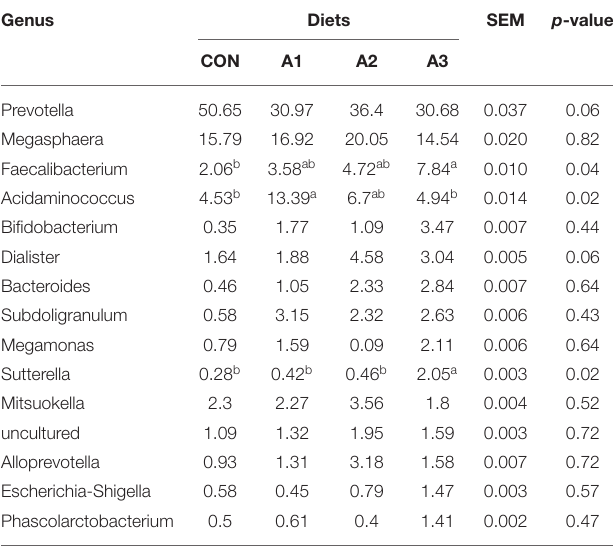
TABLE 7 | Effects of Anemoside B4 on the comparison of dominant genus of suckling calves at 56 days of age (%).